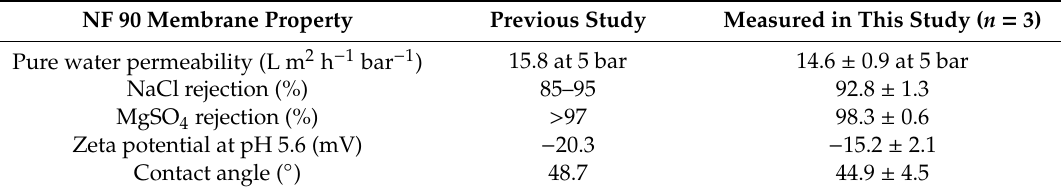
Table 1. Properties of NF 90 membrane reported in a previous study and in this study [34].